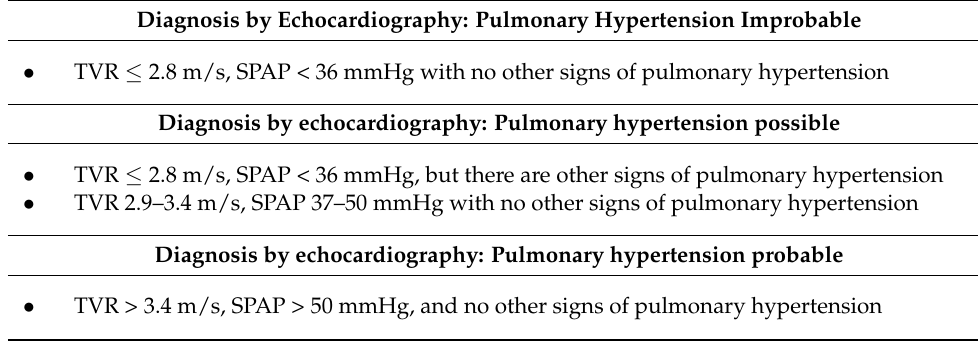
Table 1. Evaluation criteria for pulmonary hypertension by using echocardiography